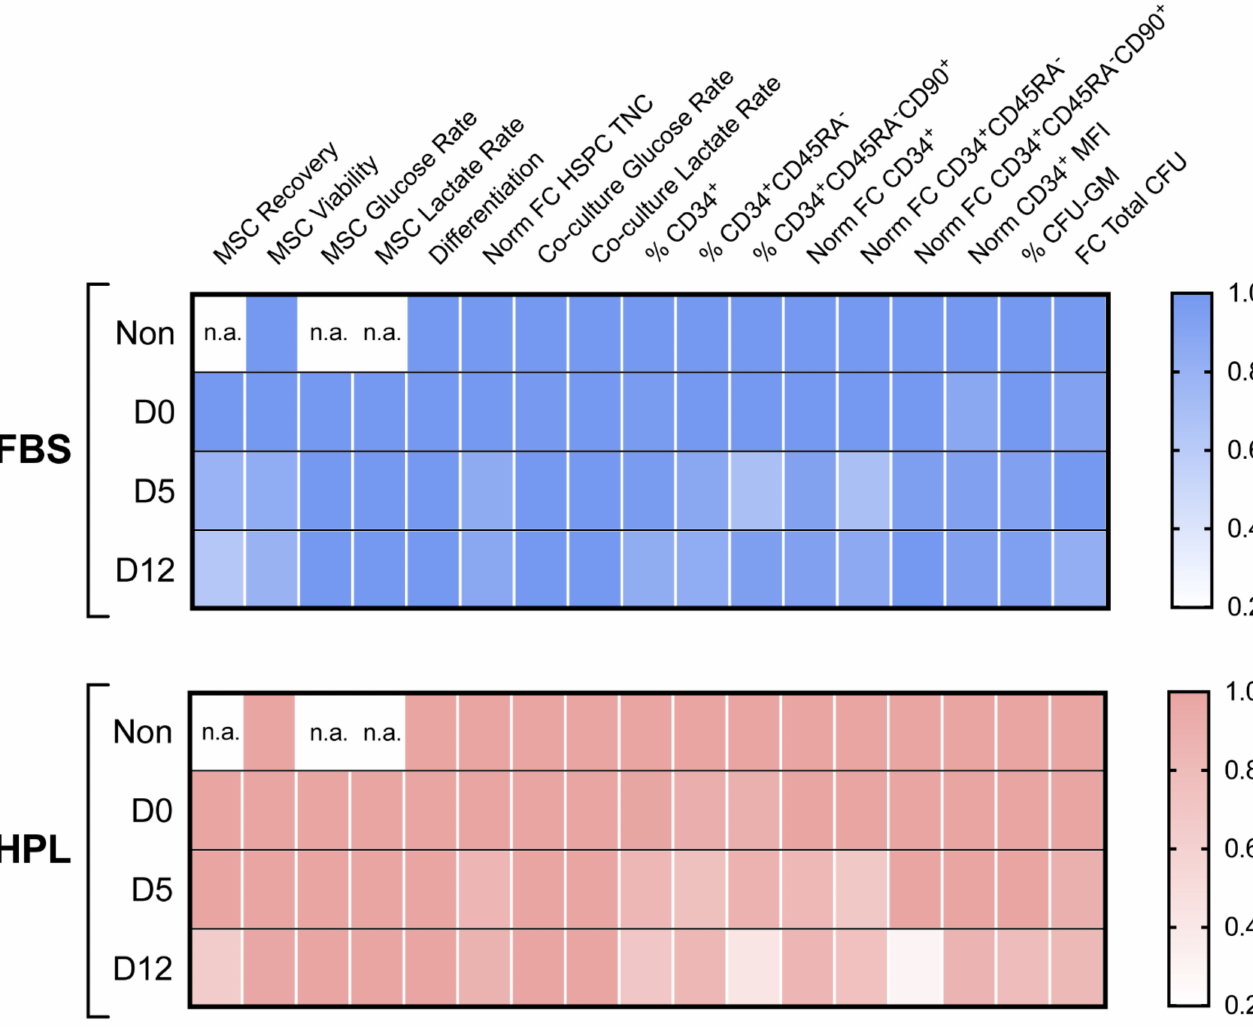
Figure 7. Heatmap score of MSC(AT) encapsulation. Key variables were put side-by-side to perform a comprehensive comparison between encapsulation timepoints for MSC-FBS ( top ) and MSC-HPL ( bottom ). Each variable was individually normalized using the value of non-encapsulated cells or D0 when non-encapsulated cells were not available. Differentiation was set to 1 for every timepoint as every differentiation was successful. Non—non-encapsulated; Glu—Glucose; Lact—Lactate; Norm— Normalized; FC—Fold Change; MFI—Median Fluorescence Intensity; n.a.—not applicable; three MSC(AT) donors;